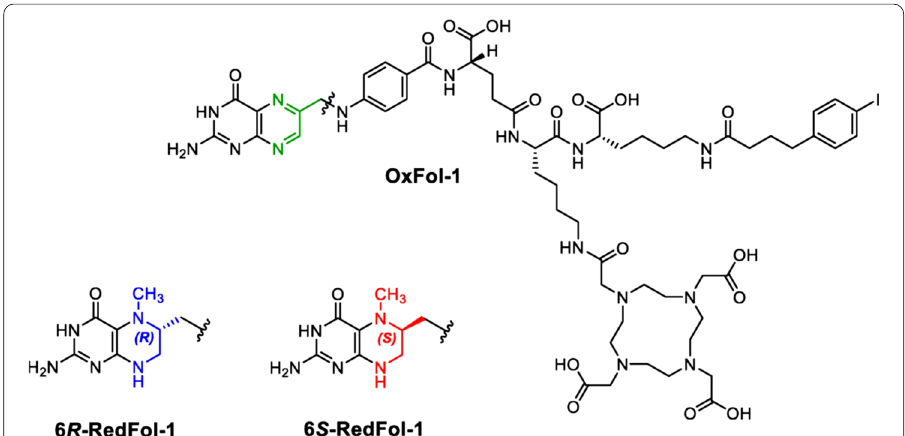
Fig. 5 Chemical Structure of Ox‑Fol‑1 (green), 6R‑RedFol‑1 (blue), and 6S‑RedFol‑1 (red). Reproduced for Guzik et al